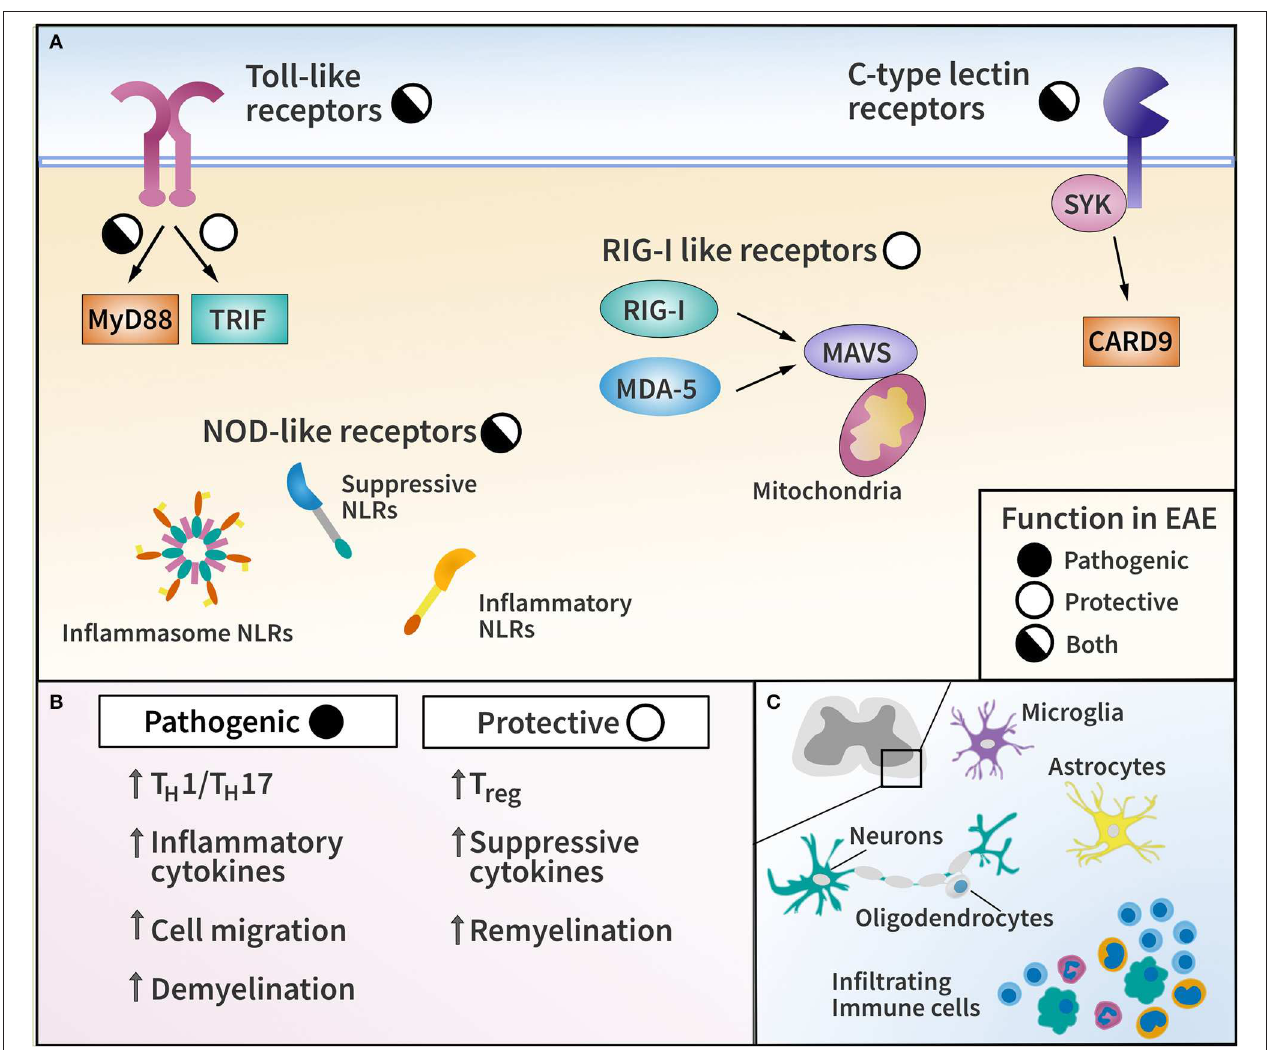
FIGURE 1 | Pattern recognition receptor (PRR) families and their functions in EAE. (A) Diagram of major PRR families with pathogenic or protective function in EAE as indicated. (B) List of representative effector mechanisms to elicit pathogenic and protective function by PRRs. (C) Diagram of CNS-resident cells and CNS-infiltrating immune cells capable of expressing PRRs in EAE and